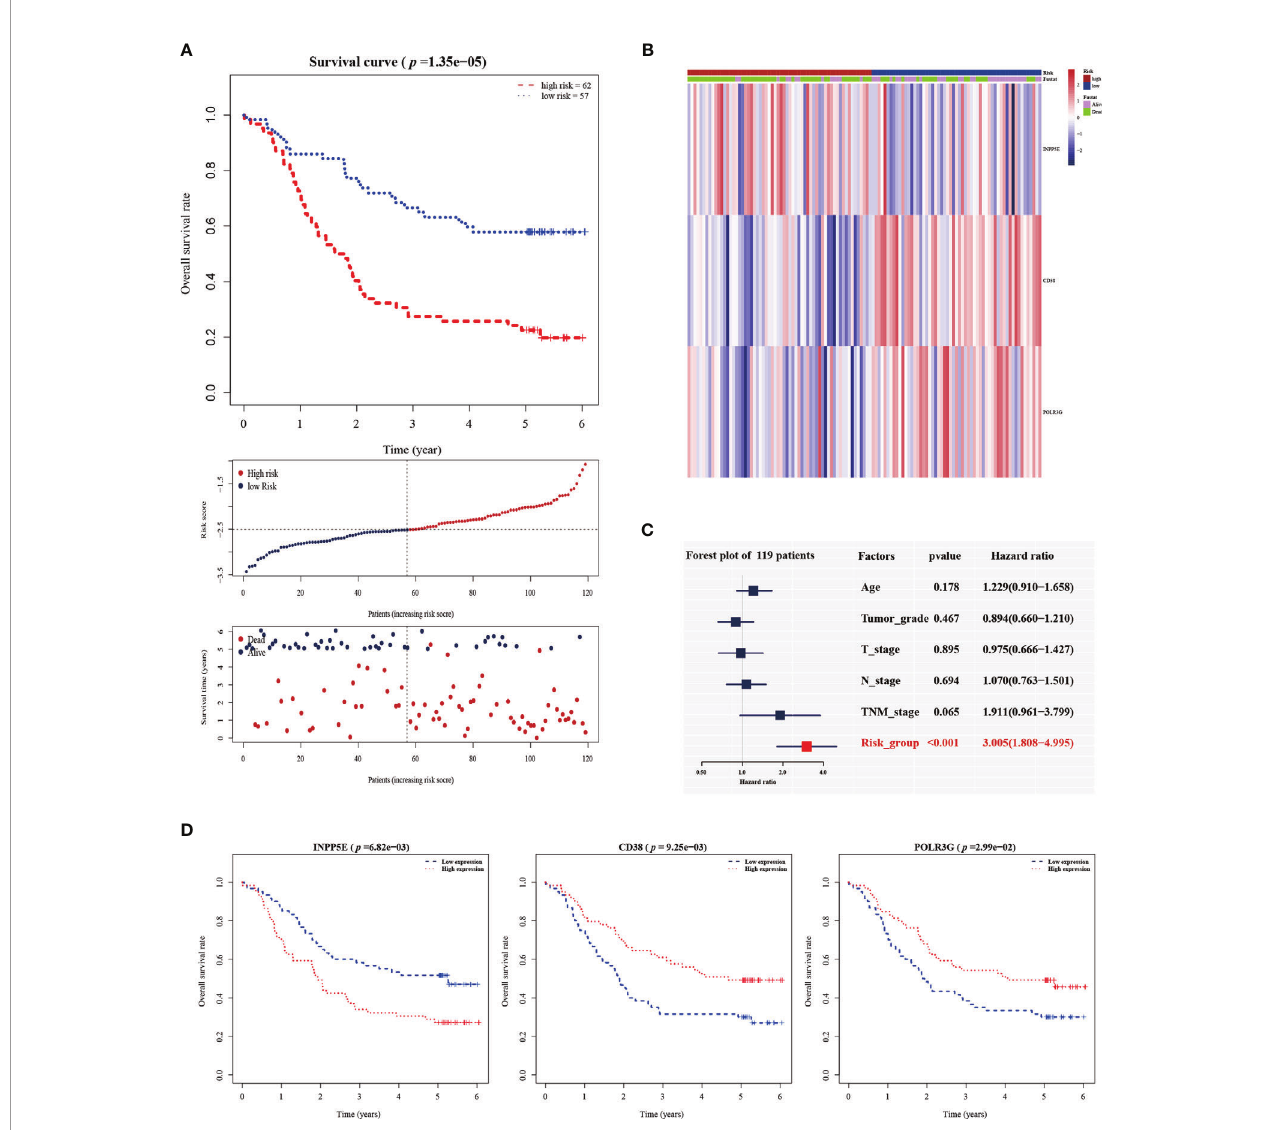
FIGURE 2 | The establishment of a metabolic-gene prognosis signature in the training group. (A) Kaplan-Meier survival analysis of overall survival, the distribution of patients ’ risk scores, and survival status for the high- and low-risk groups. (B) The heatmap of three gene signatures. (C) The independent prognostic factor of the three gene signature by multivariate Cox regression analysis. (D) Kaplan-Meier survival analysis for INPP5E, CD38 and POLR3G